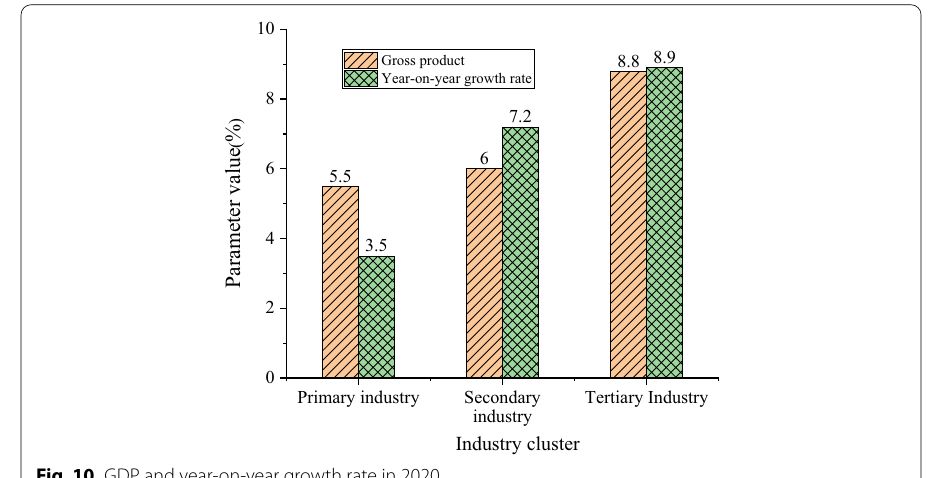
Fig. 10 GDP and year-on-year growth rate in